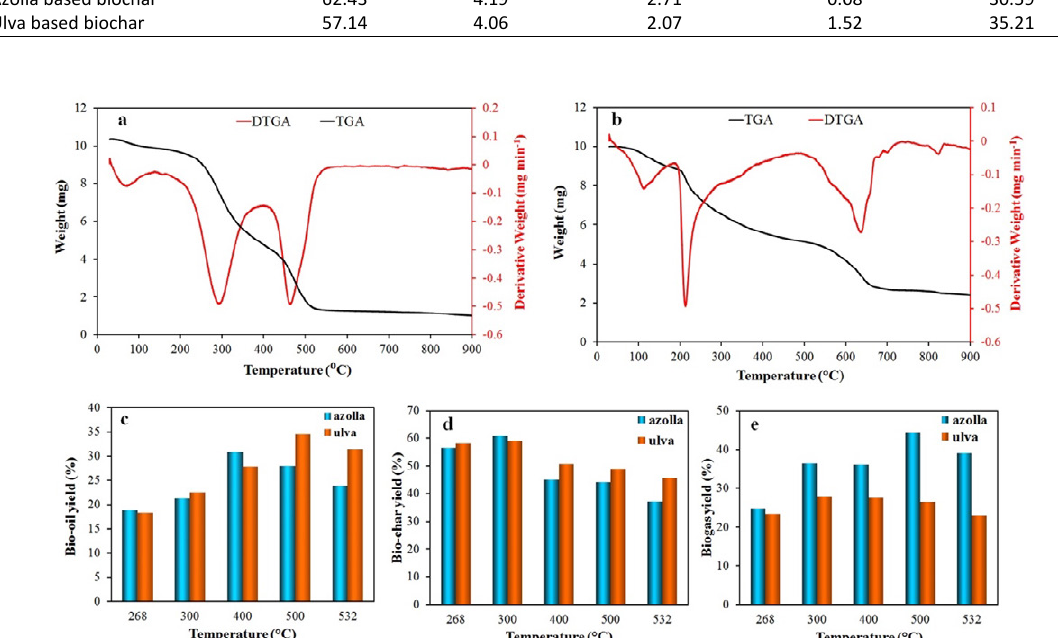
Fig. 4: Thermogravimetric curves for the pyrolysis process of (a) A. filiculoide ; and (b) U. fasciata macroalgae, and yields of the products obtained from the pyrolysis of A. filiculoide and U. fasciata macroalgae at different temperatures: (c) bio-oil yield; (d) biochar yield; and (e) bio-gas